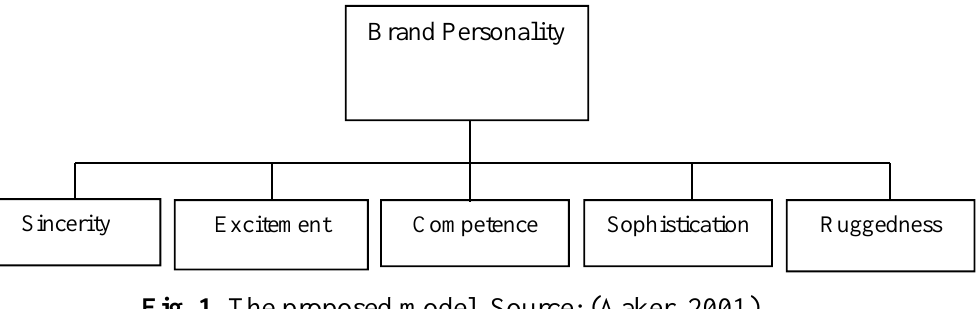
Fig. 1. The proposed model, Source: (Aaker,